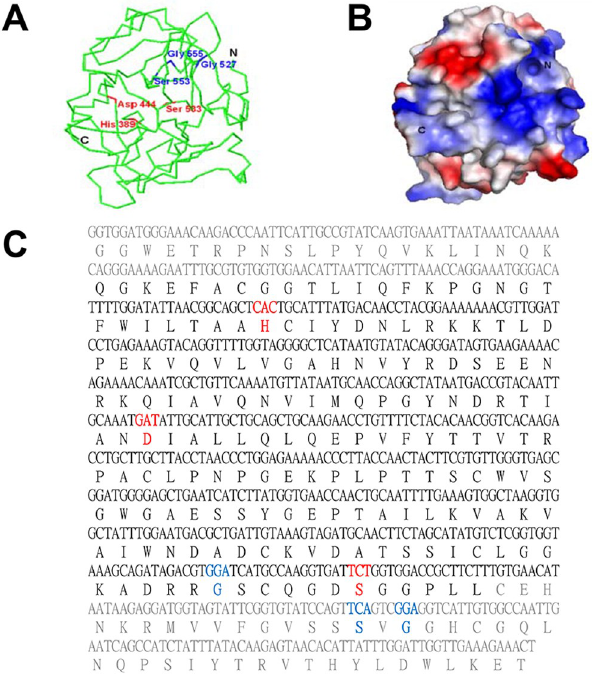
Fig 4. Representation of the 3D structure of TS 15-1c and prediction of active sites. (A) The modeled structure of TS 15-1c is shown as a C α trace representation, and (B) a surface representation. The relative distribution of the surface charge is shown with acidic regions in red, basic regions in blue and neutral regions in white. (C) Amino acid sequence of the C-terminal domain of TS 15–1. Predicted active sites (H389, D444, and S533) and substrate binding sites (G527, S553, and G555) are shown in blue and red,